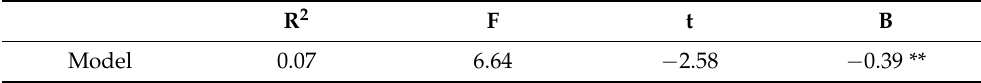
Table 4. Simple Linear Regression Analysis for Conscientiousness and Trust in e-Commerce. R 2 F t B Model 0.07 6.64 − 2.58 − 0.39 ** Note: ** p < 0.001.